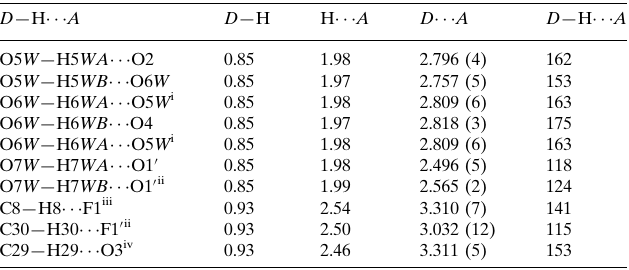
Hydrogen-bond geometry (A˚ , (cid:3)